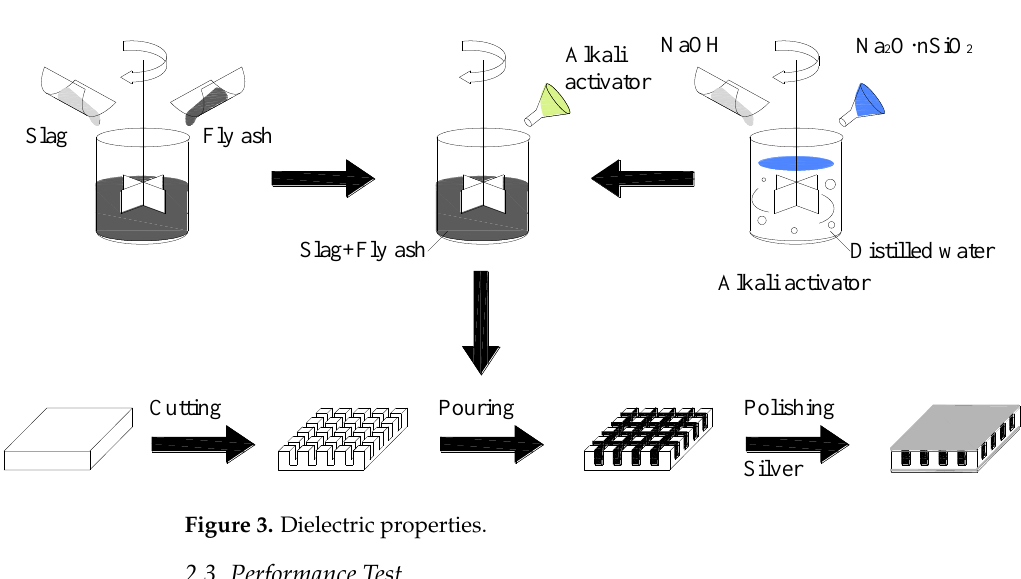
Figure 3. Dielectric properties.